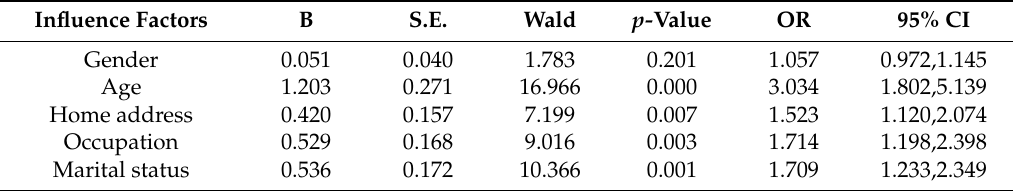
Table 7. Results of the influence factors of mental illness during heat waves of the multivariate logistic